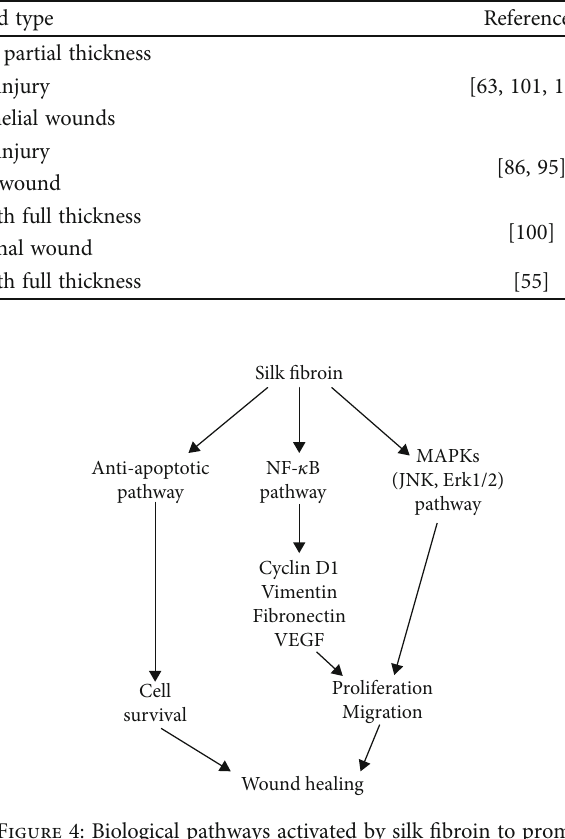
Table 1: Silk fi broin morphologic forms for di ff erent wound treatments.